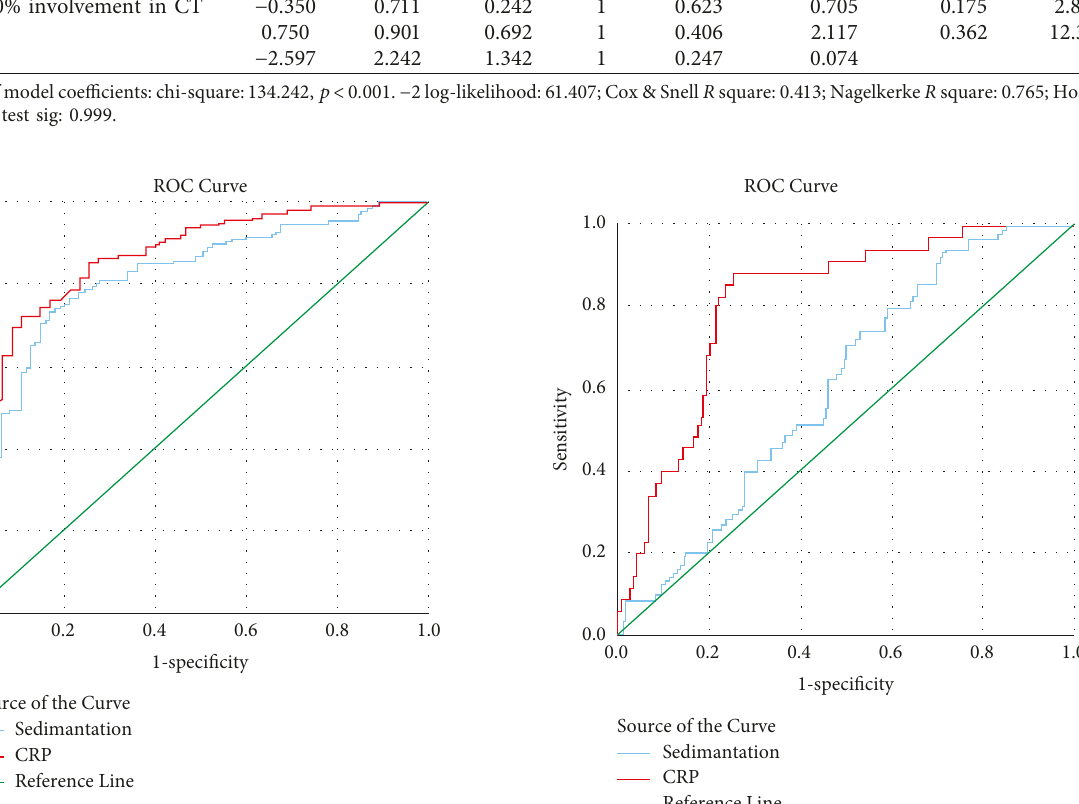
Figure 1: ROC curves for the prediction of pneumonia by sedi- mentation and